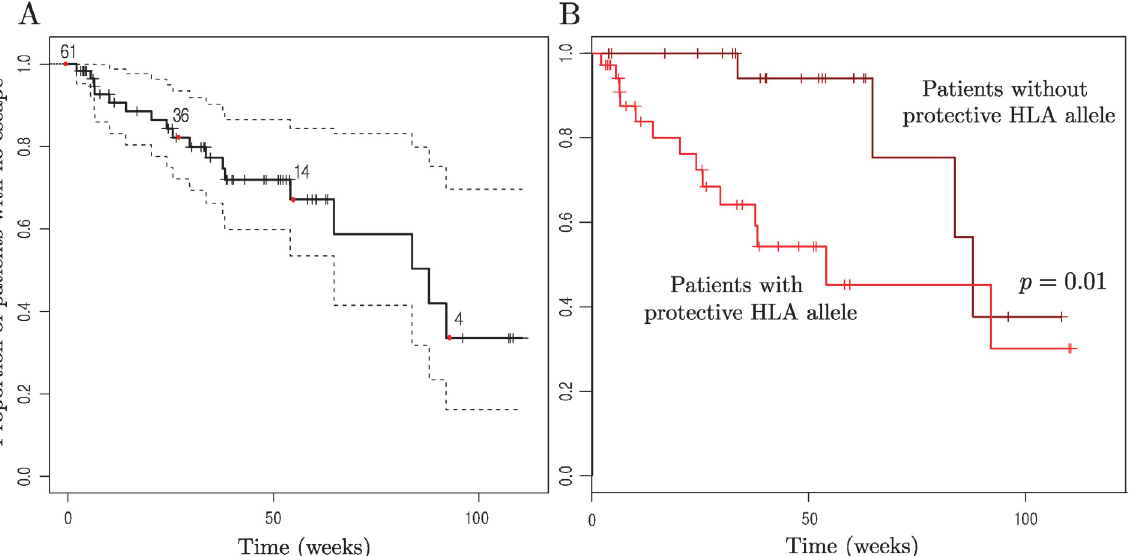
Figure 3. Kaplan-Meier plots of time to first escape using a midpoint approximation. Patients who were either missing data for gag or nef , the two genes for which the most data was available, were not included so as not to skew the results due to lack of data. 4 of these patients had no epitopes restricted by their HLA types that were WT at baseline, so n = 61 initially here. (A) Time to first escape in an HLA-restricted epitope (solid line) is plotted along with the 95% confidence intervals (dotted lines). (B) Patients are split according to whether they have one of the more ‘ protective ’ HLA alleles or not. The set of beneficial alleles was taken to be B * 58, B * 27, B * 57, A * 26, B * 51, A * 11, B * 14, B * 18, B * 08 (all the HLA-A and-B alleles down to B * 08 that are present in our data, taken from the ranking in [47]) as this split the patients approximately in half. Having a protective HLA resulted in a significantly increased risk of HLA- matched escape (p = 0.01, Likelihood Ratio test on Cox Proportional Hazards model with single predictor. Hazard ratio = 3.7, 95% C.I. = (1.2, 11.3)). In both plots the x-axis represents the time since cessation of treatment, or baseline for those not receiving treatment, and vertical checks mark time points at which patients were censored (either because they began long term ART or because there was no further sequence data available for them). Numbers indicate the number of patients who have not yet escaped or been censored at the corresponding time points marked by red dots (0, 27, 55, 93 wks).